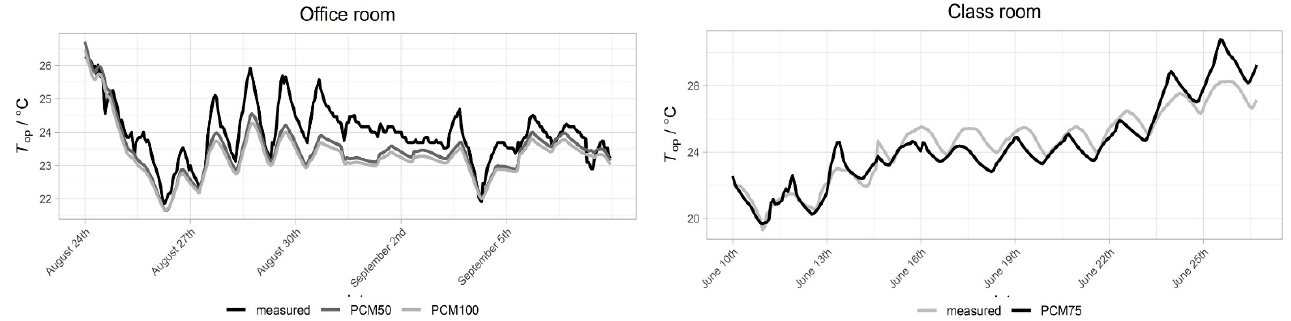
Figure 8. Validation of both models. Simulation results with and without PCM are shown for comparison reasons, respectively.